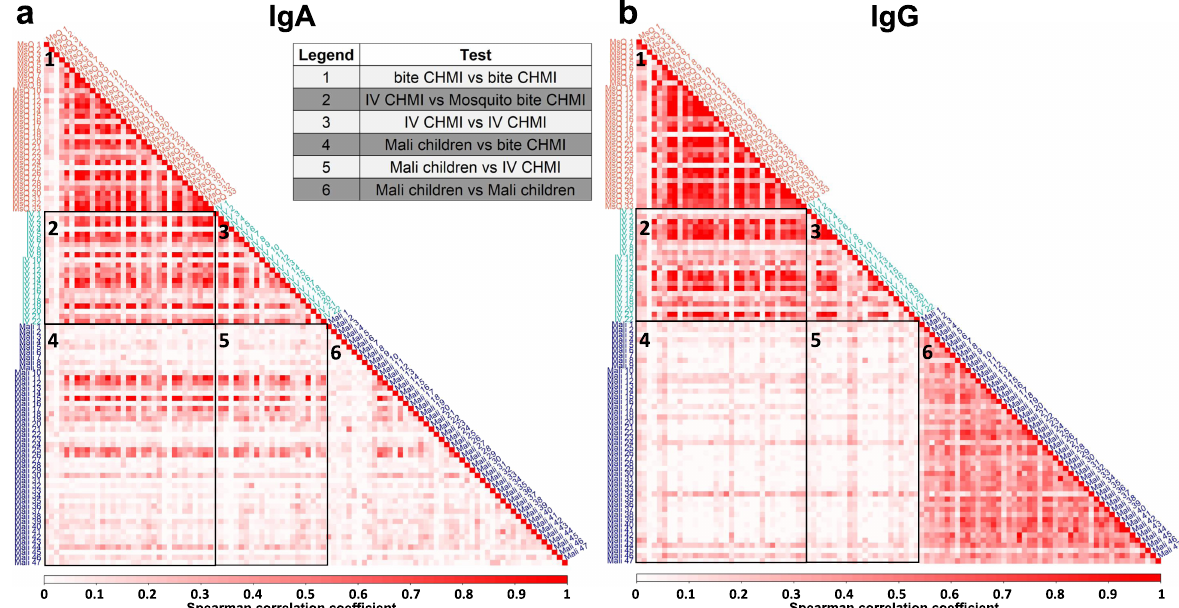
Fig. 2 Two CHMI studies induced similar P. falciparum antibody pro fi les for IgA and IgG. IgA ( a ) and IgG ( b ) pairwise correlation matrices of the distribution of fl uorescence intensity values across all proteins for each post-infection sample from three clinical studies show qualitatively different patterns of correlation. The color bar below each matrix shows the degree of correlation; the intensity of the color of the squares (light to dark red) is proportional to the value of the corresponding Spearman correlation coef fi cient. Samples were clustered based on the study comparison with each correlogram represented by a number as per the legend table. Samples for the Malian children were ordered by age of the participant. IgA correlation between the CHMI groups and the Malian children (more intense vs. less intense rows in panels 4 and 5) were used to subset the Malian children into a highly correlated group ( n = 10) and a low-correlation group ( n = 37).